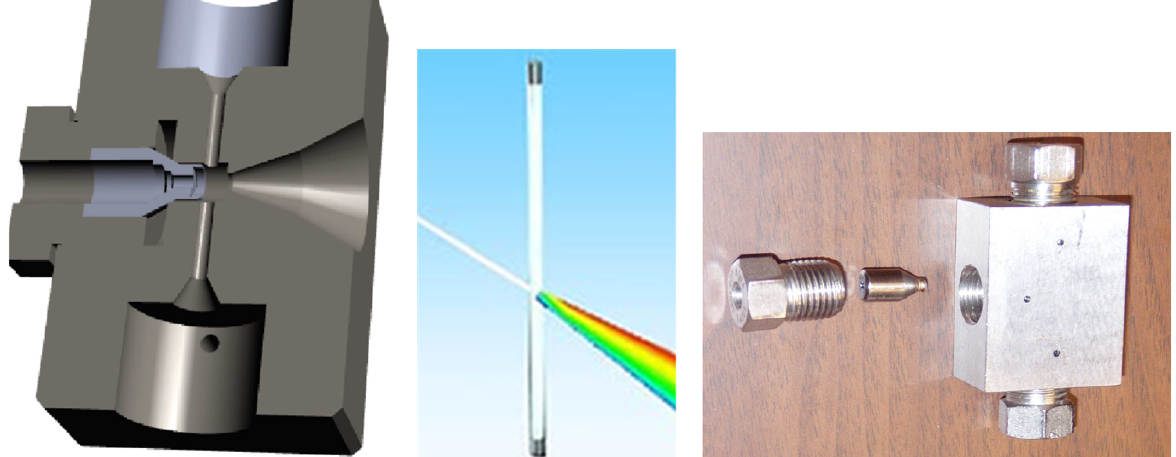
Figure 7: Horizontal cut through the hydrostatic high pressure cell (left) and the flexible polymer capillary (diameter 1.5 mm) containing the sample which fits into the central channel of the cell (middle). The beam passes from the left (entrance window) to the right (exit-window). The picture to the right shows the actual cell used at the SAXS-beamline at ELETTRA with the entrance window detached. On the right and lefts sides of the cell the high-pressure tubings for the pressure transmitting fluid (water) can be